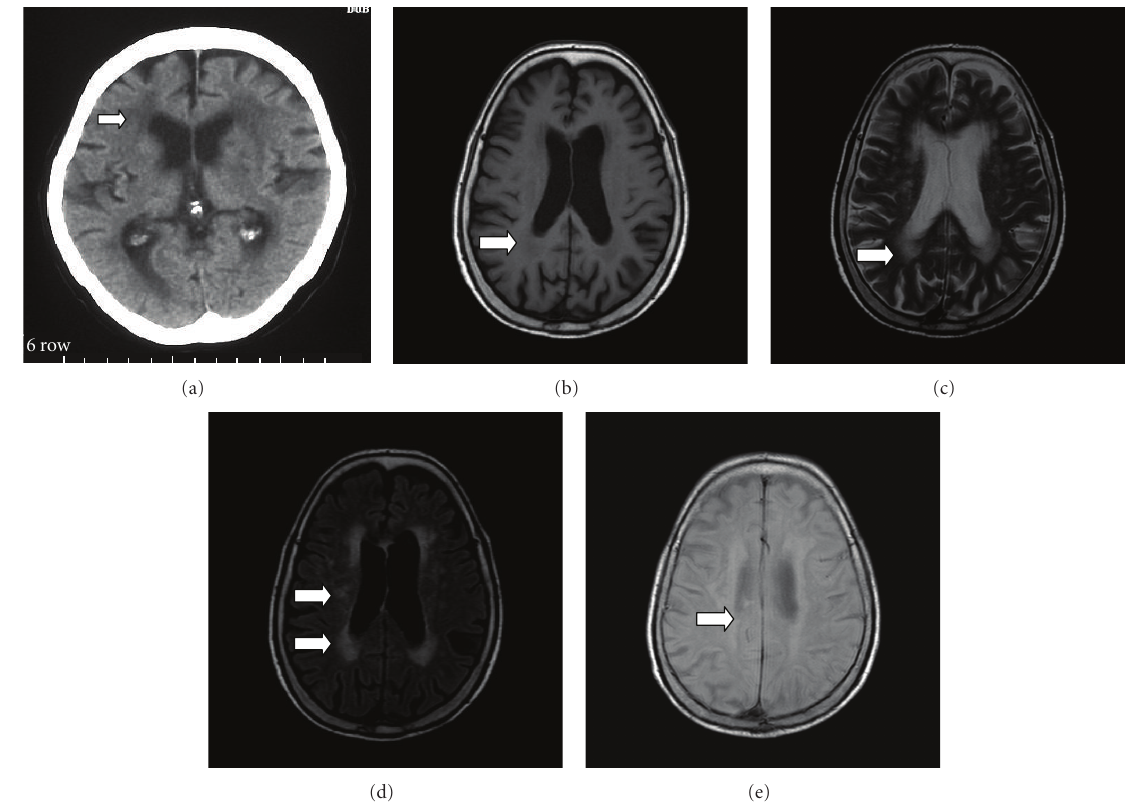
Figure 1: WMC on CT and MRI. (a) Hypodensities on CT; (b) hypointensities on T1-weighted MRI; (c, d, e) hyperintensities on T2- weighted MRI, proton-density, and FLAIR sequences, respectively. (d) The lower arrow shows the PVWMC, and the upper one shows the